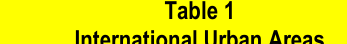
International Urban